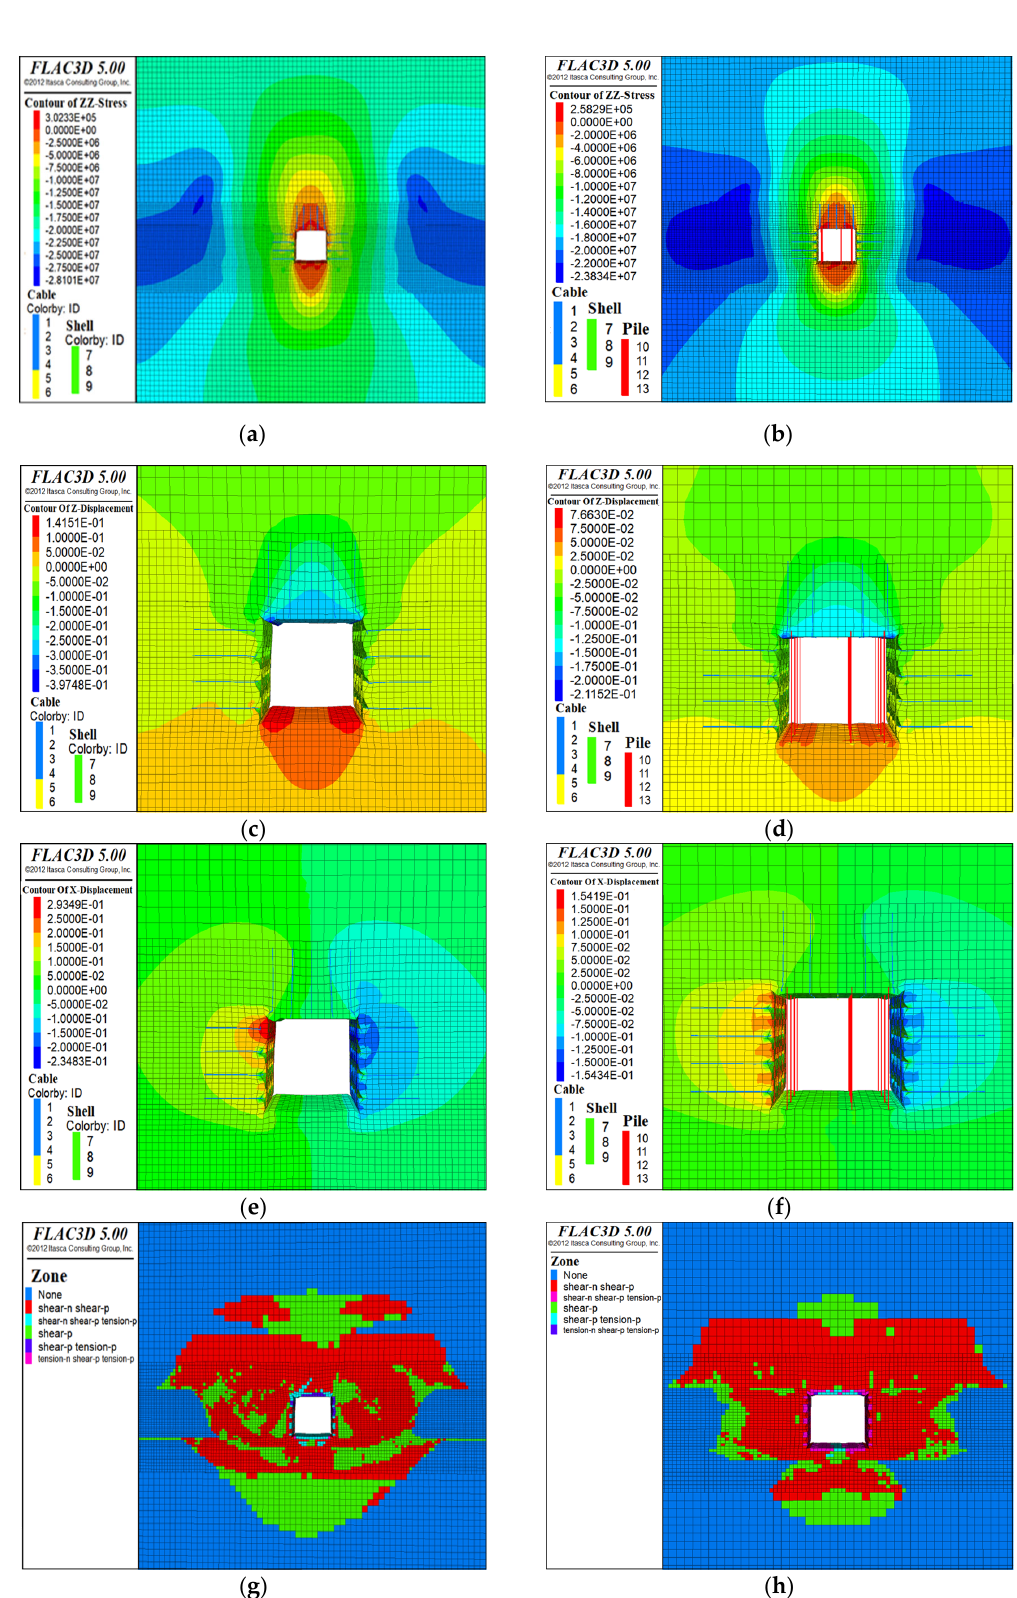
Figure 12. Cloud map analysis of schemes 1 and 2. ( a ) Scheme 1: vertical stress; ( b ) Scheme 2: vertical stress; ( c ) Scheme 1: vertical displacement; ( d ) Scheme 2: vertical displacement; ( e ) Scheme 1: horizontal displacement; ( f ) Scheme 2: horizontal displacement; ( g ) Scheme 1: plastic zone distribution; ( h ) Scheme 2: plastic zone distribution.